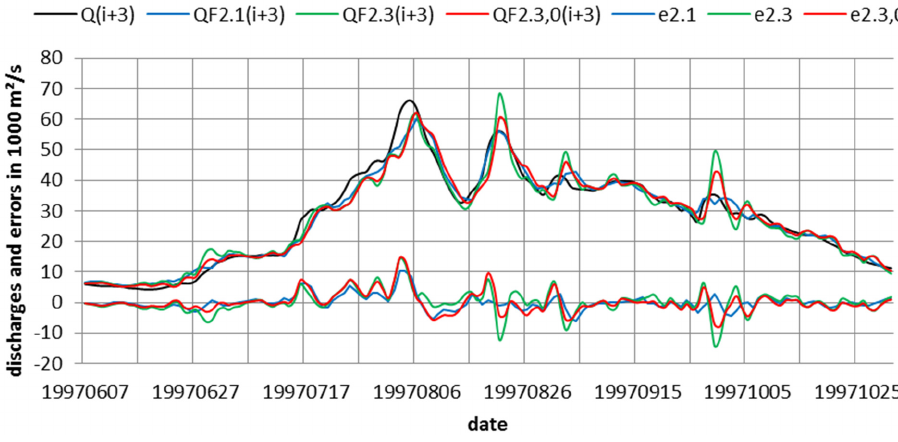
Figure 3. Forecast results for 3 days with model 2.3 and linear combination of model 2.3 with model 0 for Stung Treng in 1997. Additionally shown is the forecast of model 2.1.